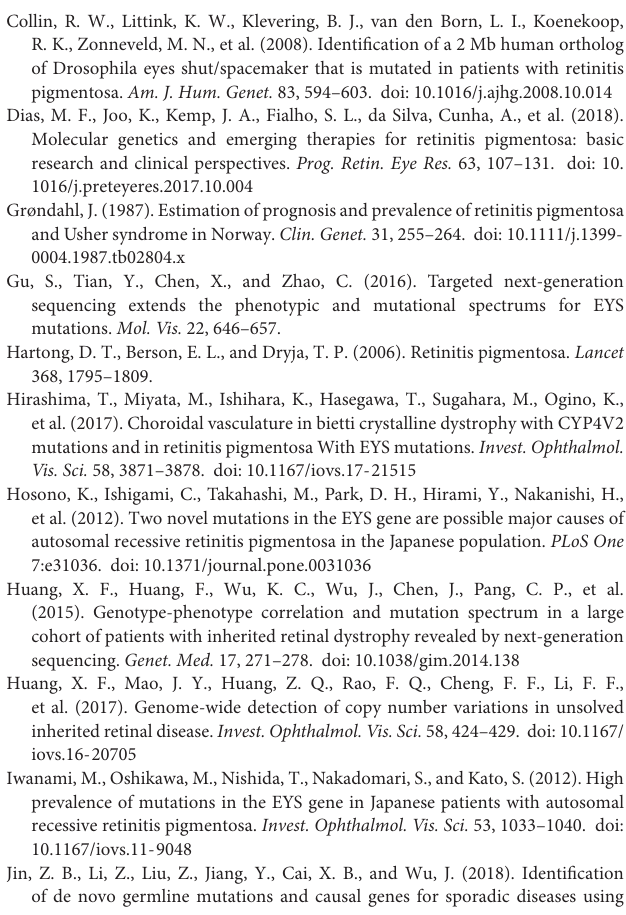
Supplementary Figure 1 | Family pedigrees and identified EYS variations for G1 cohort. The generation number and EYS genotypes for probands and their family members are demonstrated under their symbols. The Black filled square s (male) and circles (female) represent the affected patients, and unaffected family members are represented by unfilled icons. The slash symbol indicates deceased member. Probands are marked by